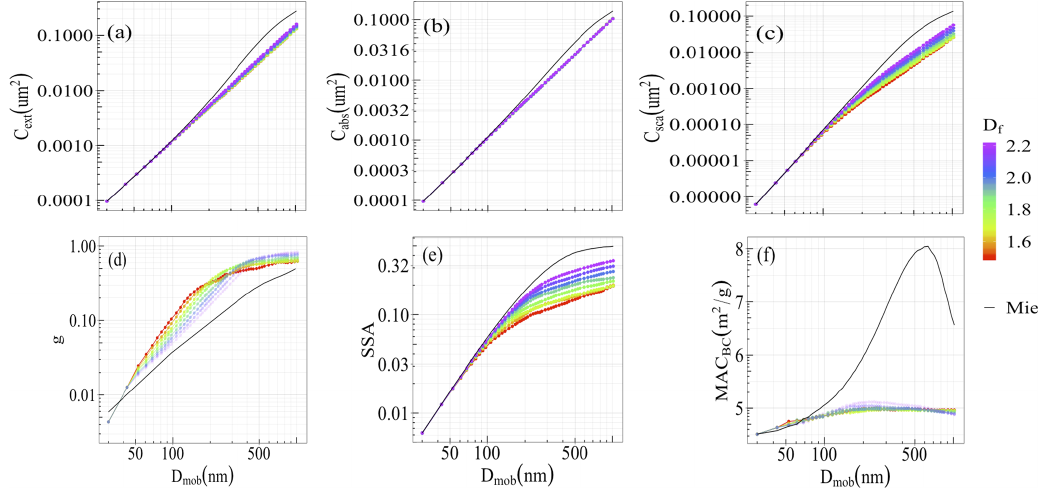
Figure 8. Optical properties of coated BCFAs ( f organics = 50%) as a function of D mob at various fractal dimensions ( D f ): (a) extinction cross section C ext , (b) absorption cross section C abs , (c) scattering cross section C sca , (d) asymmetry parameter g , (e) single-scattering albedo (SSA), and (f) black carbon mass absorption cross section MAC BC at λ =